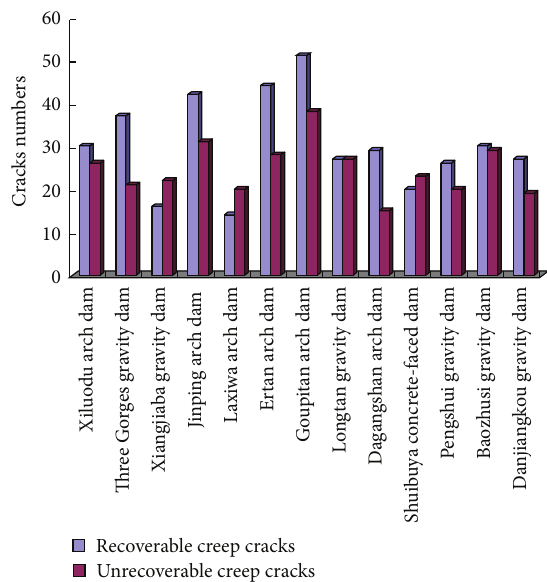
Figure 11: Temperature creep cracks development of Sino